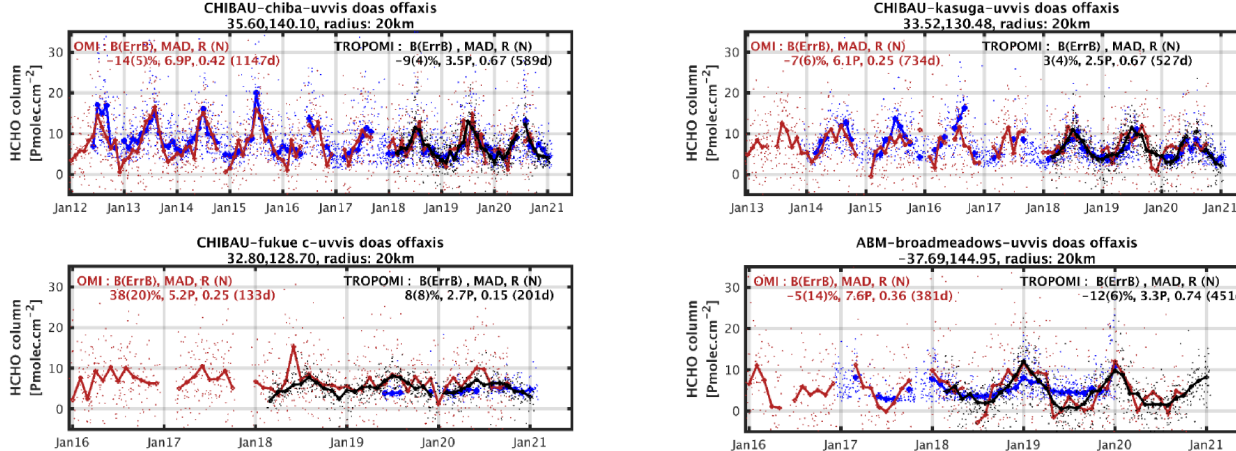
Figure 13. Same as Fig. 12 in Japan and Australia.